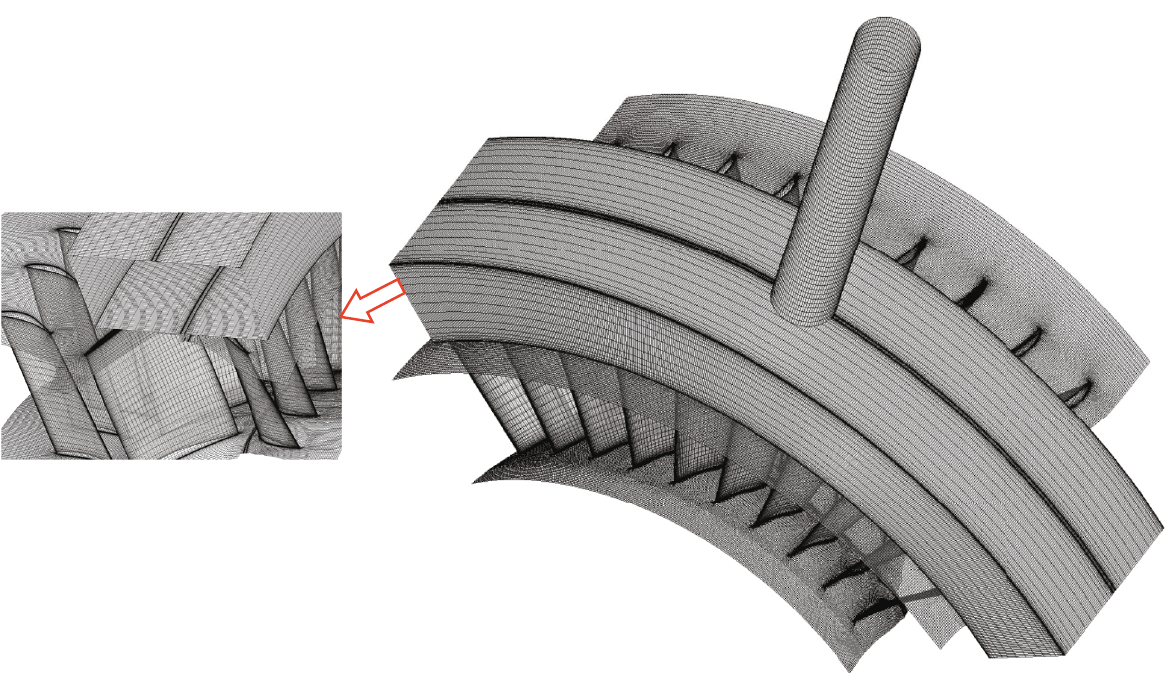
Figure 2: Structured mesh of compressor bleed